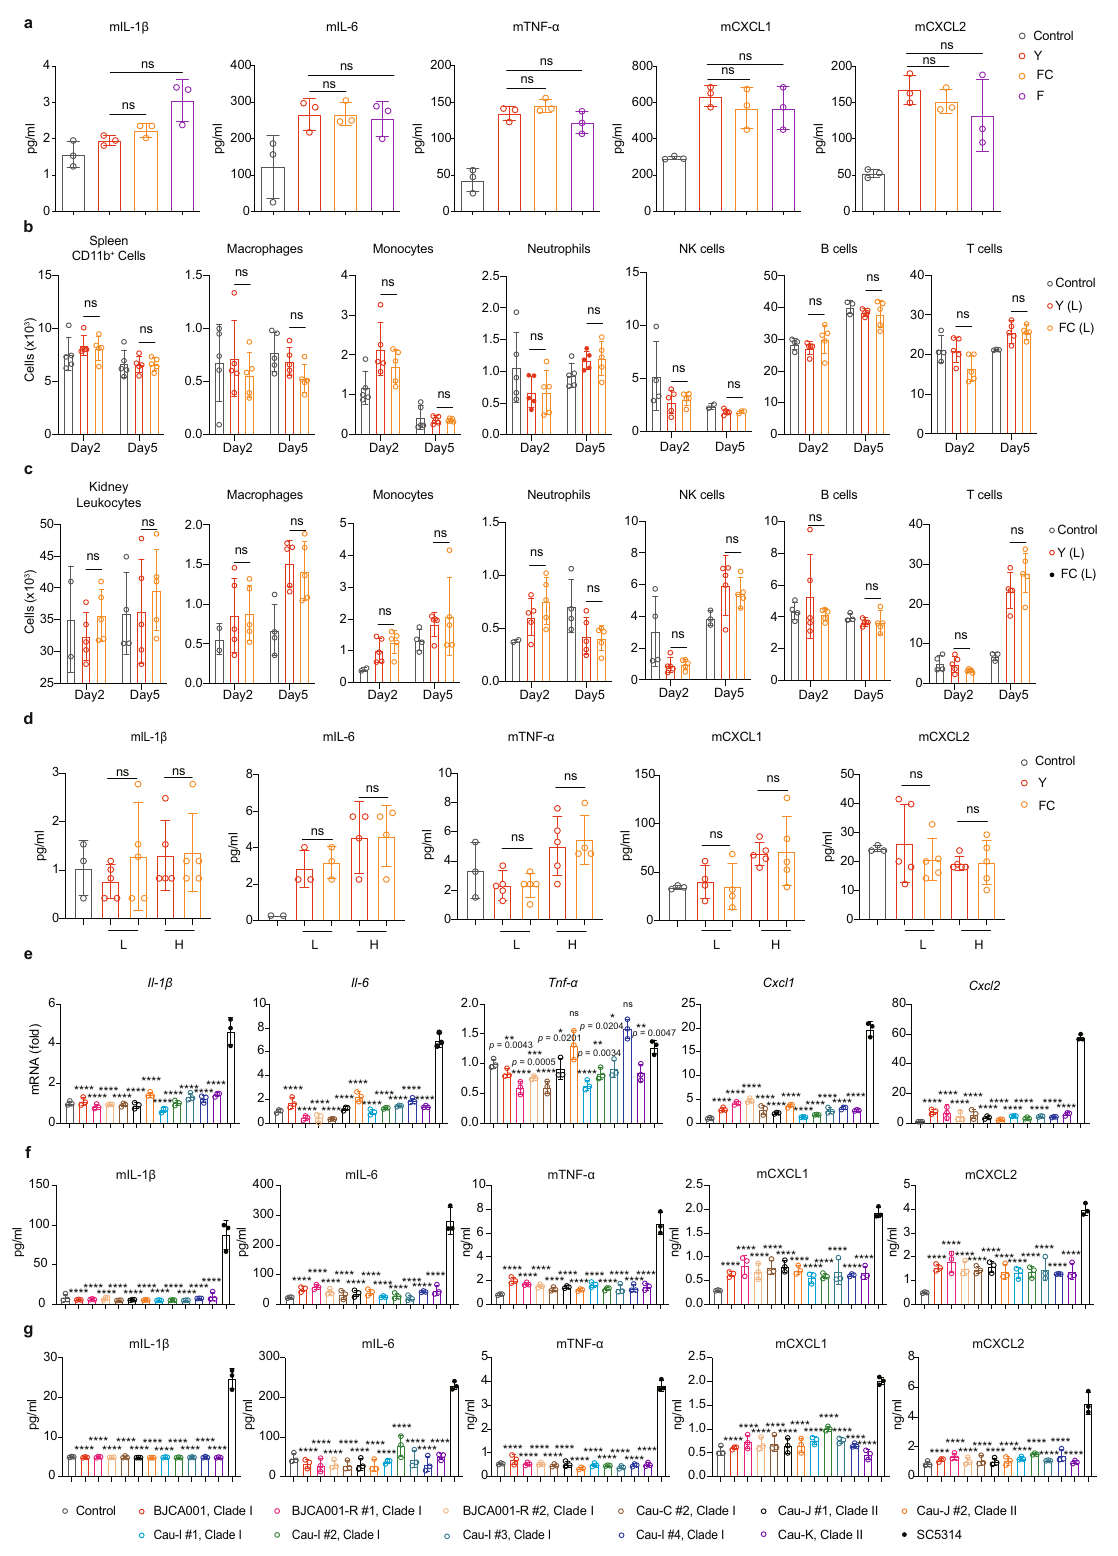
β -glucan, and chitin 35,36 . Meanwhile, the fi brillar outermost layer consists of mannosylated glycoproteins and the inner layer is sequentially assembled with β -glucan and chitin 35,36 . Upon infection, pathogenic fungi expose speci fi c pathogen-associated molecular patterns (PAMPs) at their cell surface that could be recognized by host pattern recognition receptors (PRRs)